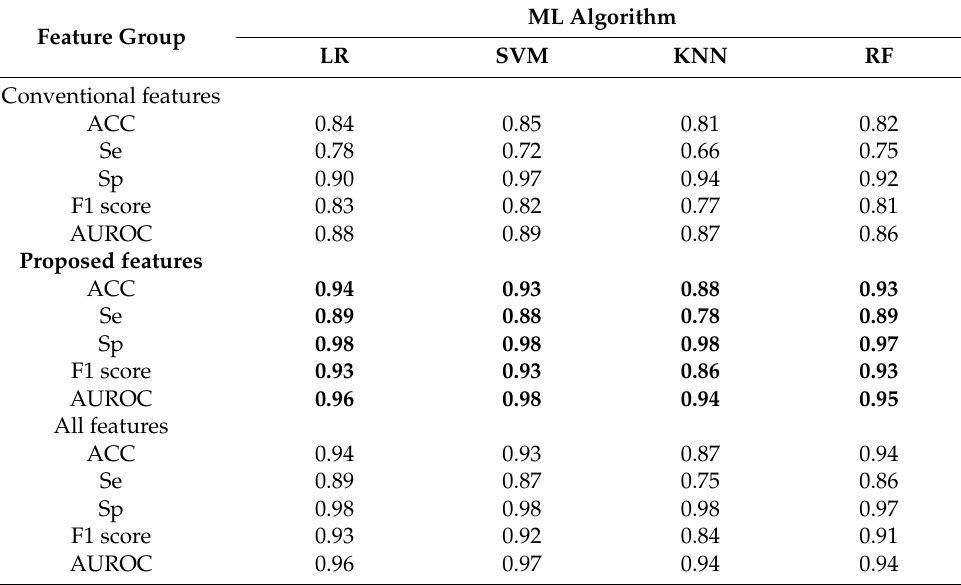
Table 2. Feature group classification evaluation metrics (the proposed feature results marked with bold text). ACC—accuracy; Se—sensitivity; Sp—specificity; AUROC—area under the receiver operating characteristic curve.